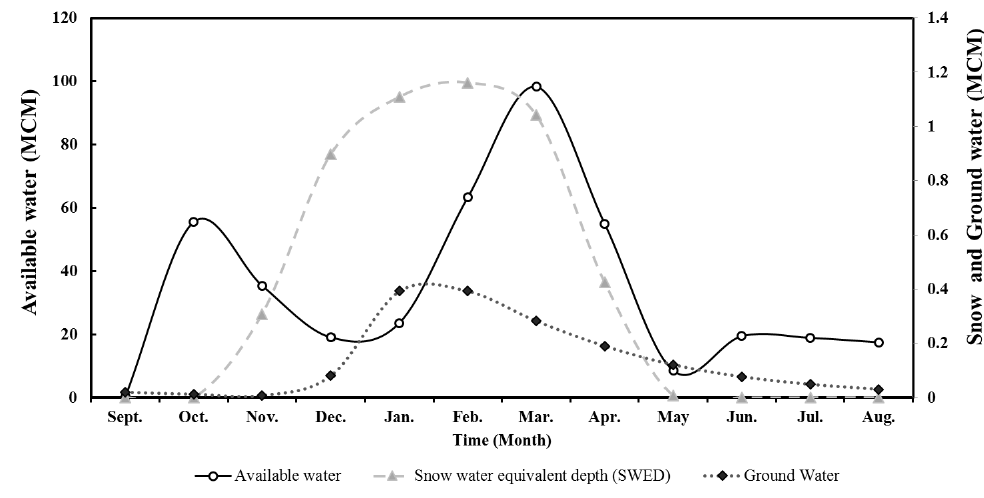
Figure 7. Available water, SWED, and Ground water stock simulation results.